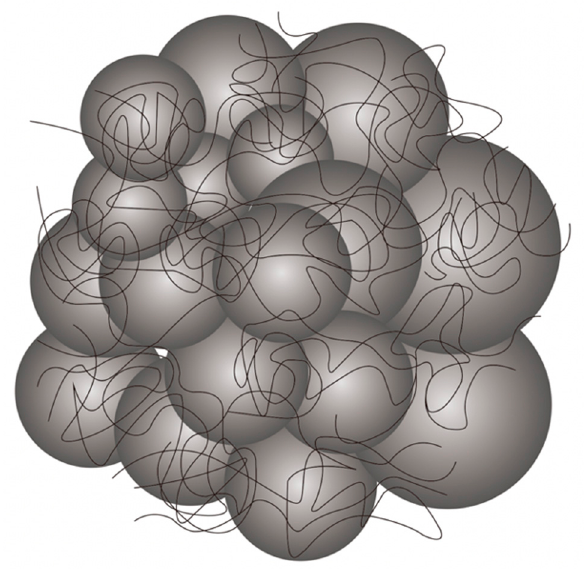
Figure 1. A schematic representation of the structure of close-packed crosslinked and swollen Carbopol ® gel particles. (Adapted from Shafiei et al. [20] with permission from Elsevier). Aqueous dispersions of such crosslinked polymer gels can be prepared over a range of conditions, concentrations, and pH. Figure 2 shows the fluorescence micrographs of Carbopol ® hydrogels at various concentrations of Carbopol ® [22]. At low concentrations of Carbopol ® there are no visible interactions and clustering of swollen particles. However, when the concentration of the Carbopol ® reaches 0.1% by weight agglomeration and clustering of the soft particles can be observed [22]. In fact, at 0.1% by weight (Figure 2d), the particle clusters span the length of the sample to generate a microgel. The onset of the jamming of the swollen particles with increasing concentration gives rise to elasticity and gel-like behavior. Such network formation is the basis for the development of a yield stress for the hydrogel which demarcates the boundary between solid-like and fluid-like behavior. Piau observed that the clustering of the crosslinked particles can span the entire volume above a critical concentration at which a percolated network is developed [23].